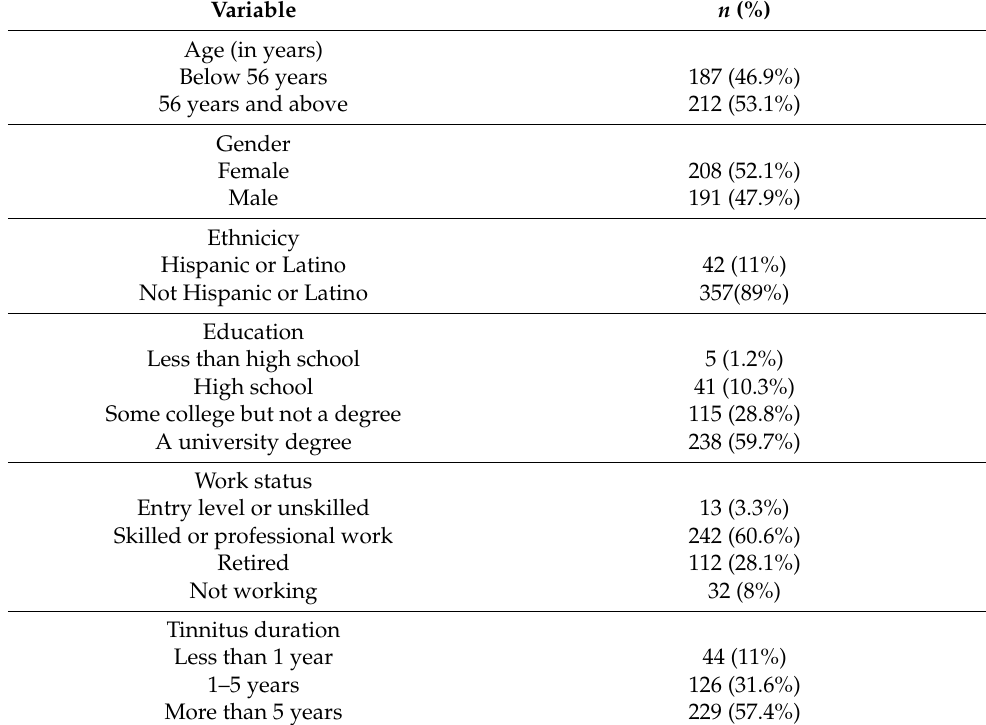
Table 1. Demographic details ( n =